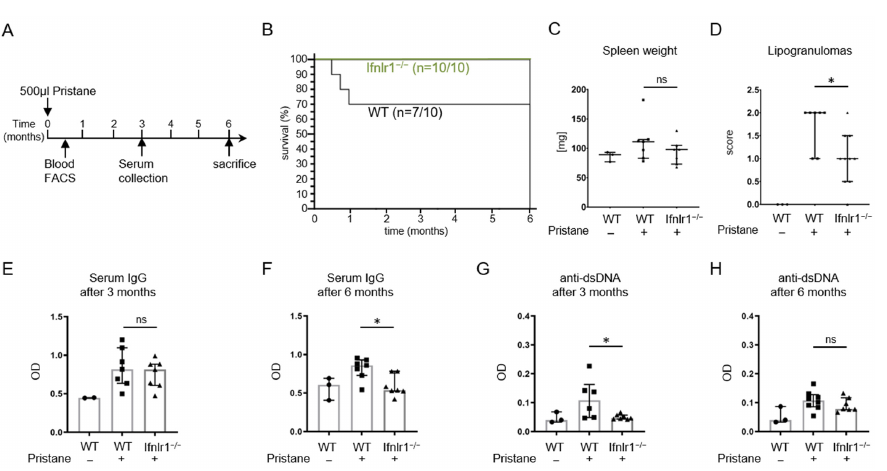
Figure 1. Experimental design, survival and autoimmunity parameters. ( A ) WT and Ifnlr1 − / − mice were intraperitoneally injected with 500 µL of pristane and sacrificed after 6 months. Blood and serum were collected at 2 weeks and 3 and 6 months after pristane injection. ( B ) After injection with pristane, all Ifnlr1 − / − mice survived until the 6-month time point, whereas 70% (n = 7/10) of WT mice died within the first month after injection. ( C ) Spleen weight at sacrifice. ( D ) Semi-quantitative scoring of lipogranulomas showed decreased lipogranuloma formation in Ifnlr1 − / − mice (0 = none; 1 = low; 2 = moderate and 3 = high numbers of lipogranulomas per mouse. ( E , F ) Total IgG levels were determined by ELISA at 3 and 6 months after pristane treatment. ( G , H ) Anti-dsDNA-IgG levels were determined at 3 and 6 months after pristane treatment by ELISA. Each symbol represents an individual sample and all samples were included. Bars represent median with interquartile range. Statistical analyses to compare WT + pristane vs. Ifnlr1 − / − + pristane were performed using Mann– Whitney U test. * = p < 0.05; ns = not significant. Values of WT without pristane are shown as reference. Findings were confirmed in at least one other independent experiment.